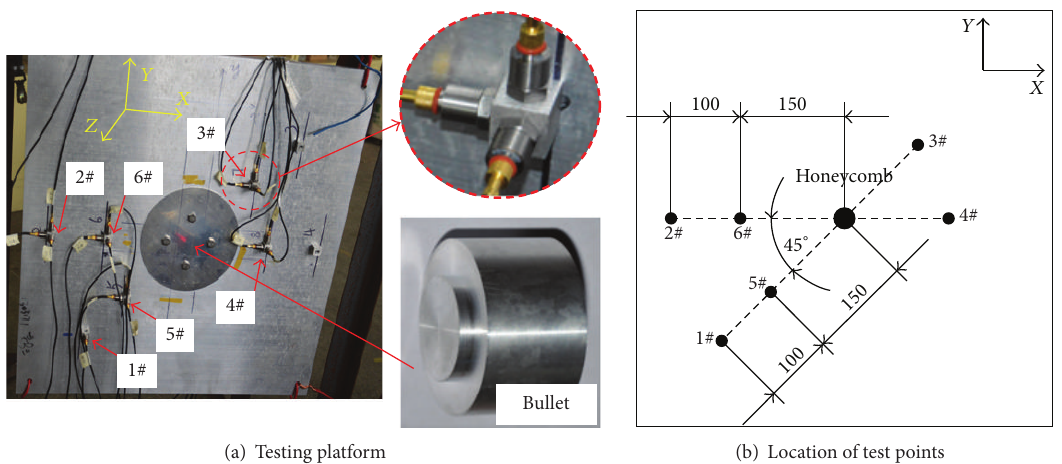
Figure 3: Experimental setup.